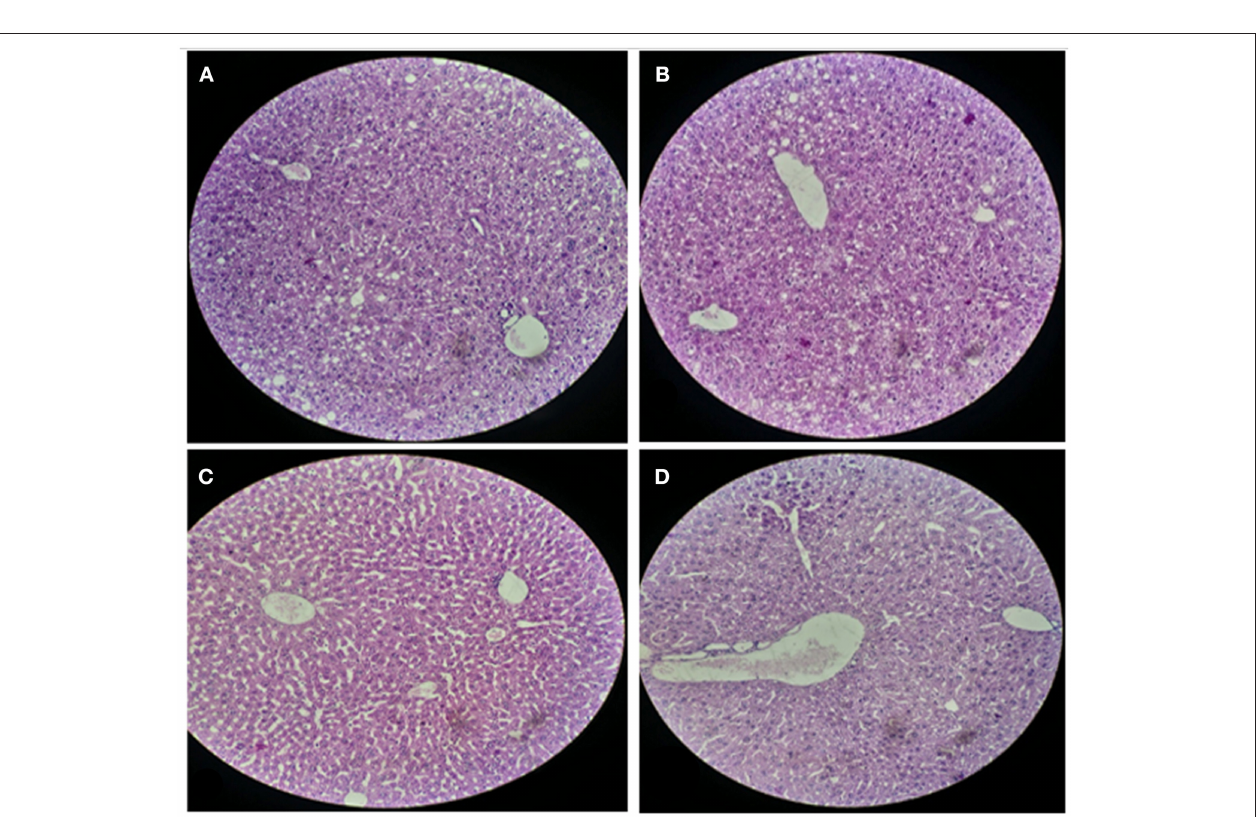
FIGURE 4 | Liver sections of mice at 20X microscope. (A,B) sections, when there is no intake of any probiotic or experimental bacterium, (C,D) sections, when micro Enterococcus mundtii QAUEM2808 was administered.